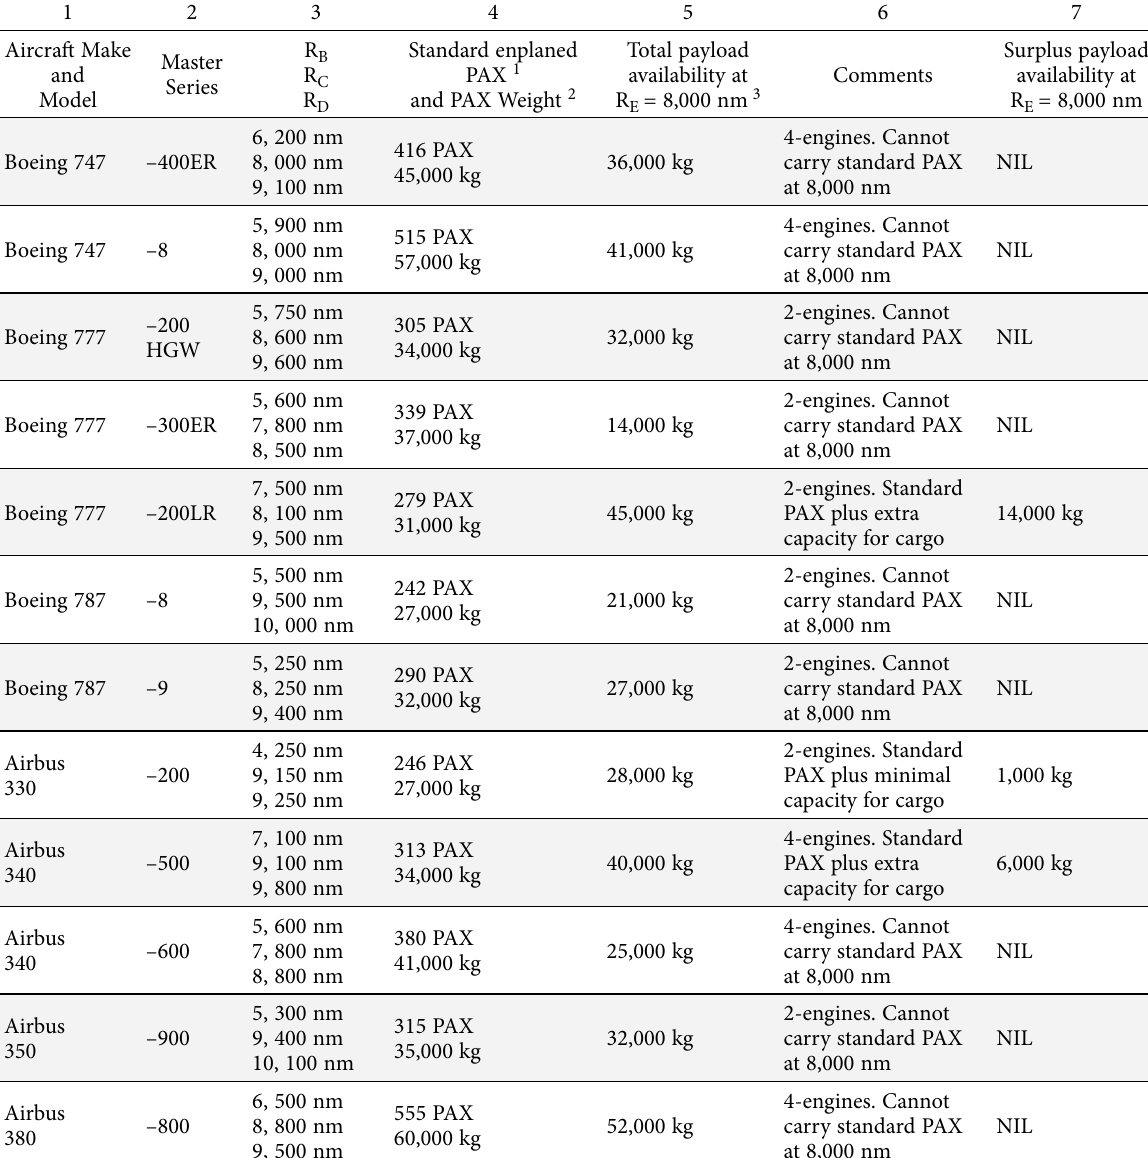
Table 1. Key performance measures for current wide bodied aircraft capable of ULR flights, including any payload availability to carry lower deck cargo. (See Section 3. 3. 2. for a sample investigation) (source: data derived from Boeing Commercial